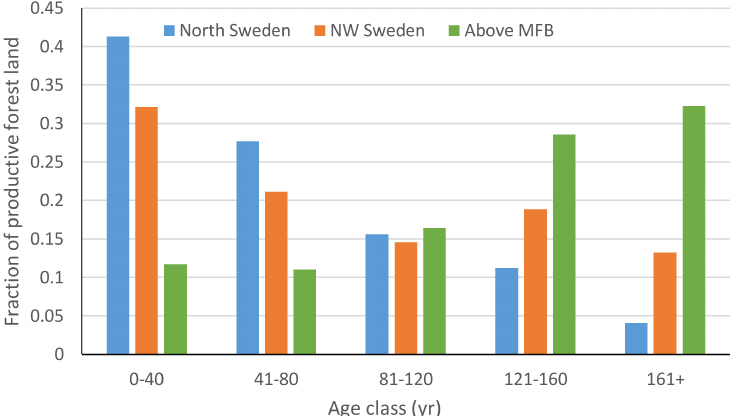
Figure 2. Age distribution of all productive forests (including protected forests) based on the Swedish National Forest Inventory (2012–2016, 5-year average) in north Sweden, NW Sweden (the 15 mountain municipalities) and above the mountain forest border (see Figure 1).